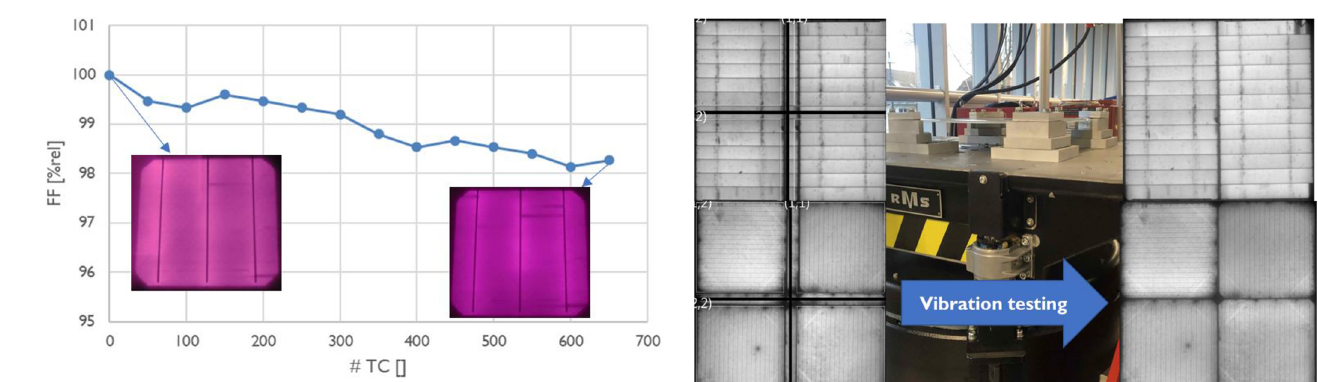
Fig. 11. EL images of GFRB samples with shingling or multi- wire interconnection before (left) and after (right) the random vibration testing carried out with a shaker (central